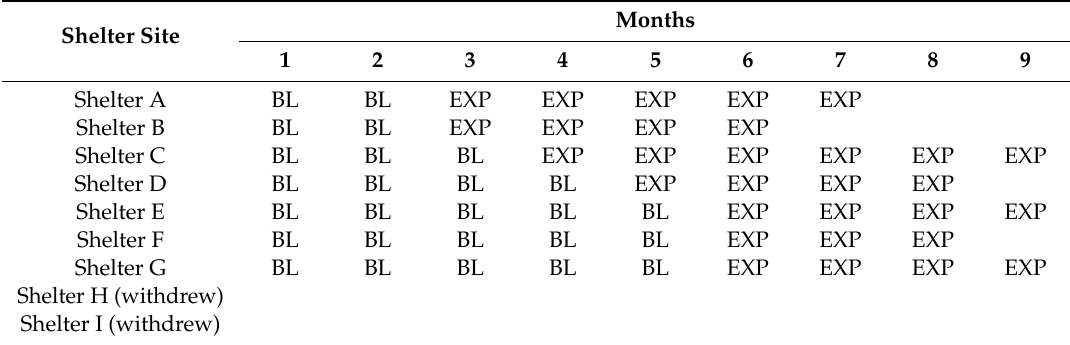
Table 1. Multiple baseline design across animal shelter